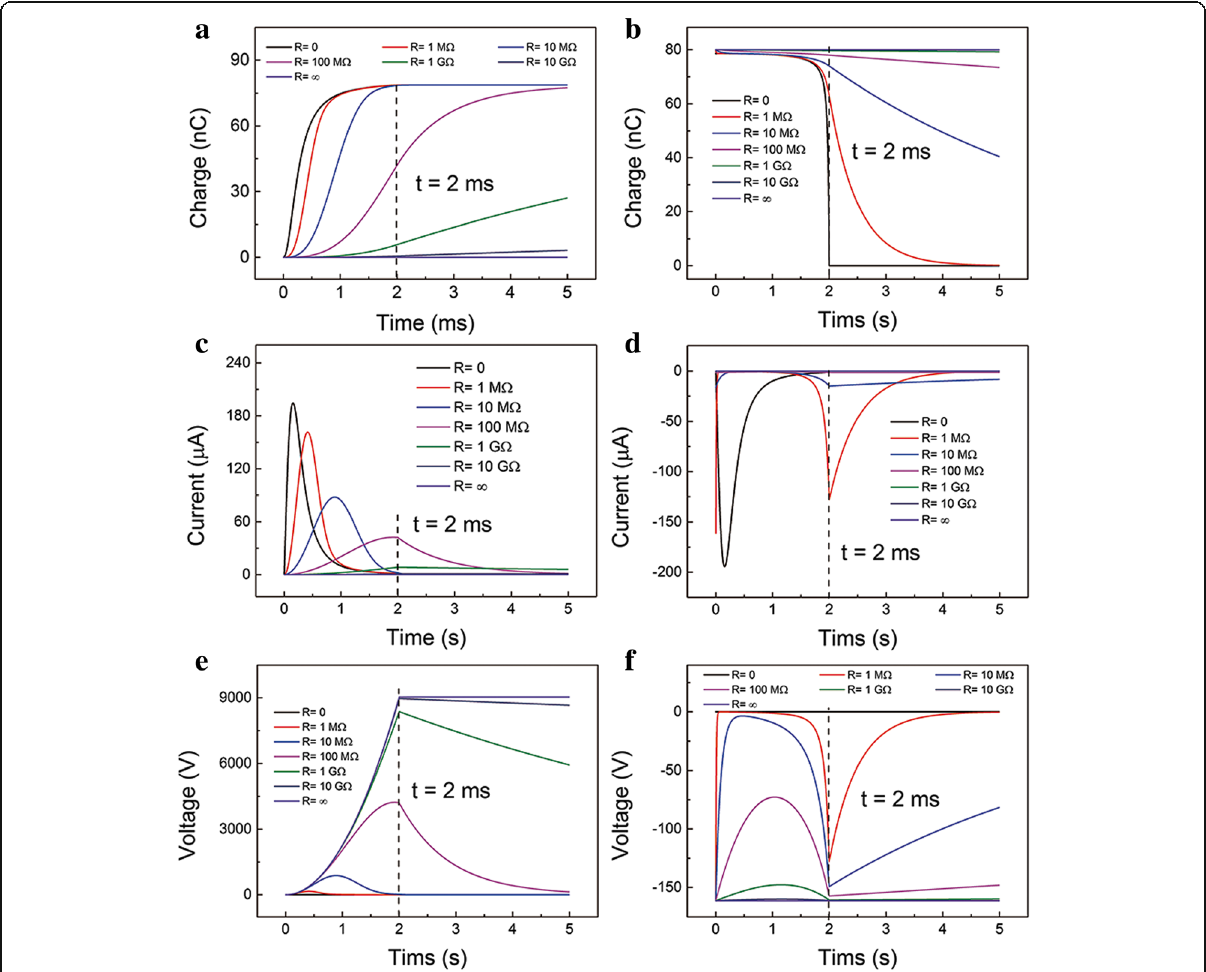
Fig. 2 Calculated output characteristics when the device is under a constant compressive force F. Transferred charges-time relationship at different R in the a contact process and b separation process. Current-time relationship at different R in the c contact process and d separation process. Voltage-time relationship at different R in the e contact process and f separation